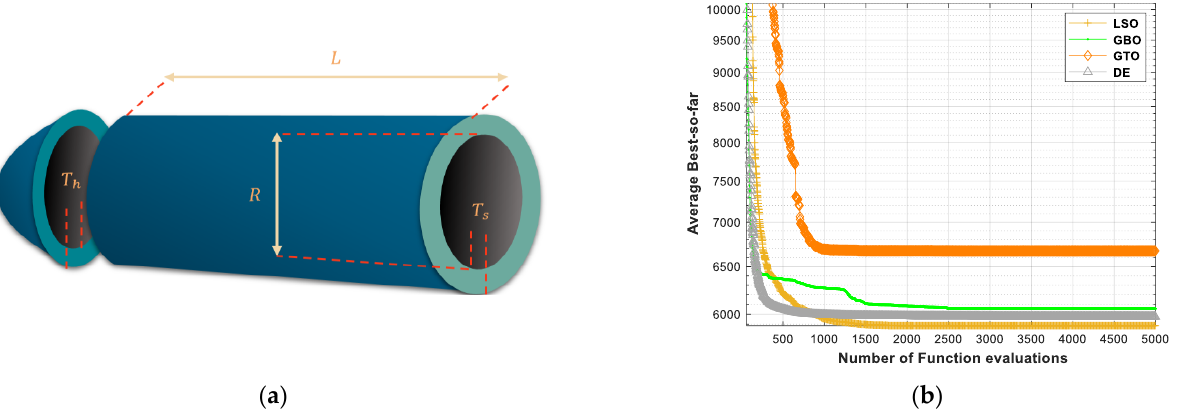
Figure 23. Pressure vessel design problem. ( a ) Structure. ( b ) Convergence curve.